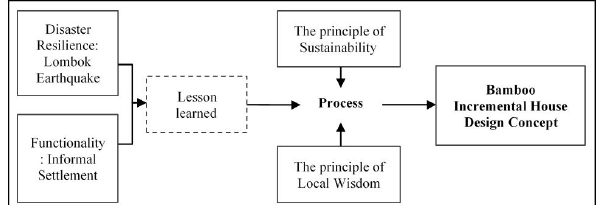
Fig. 4. Design Process Paradigm.